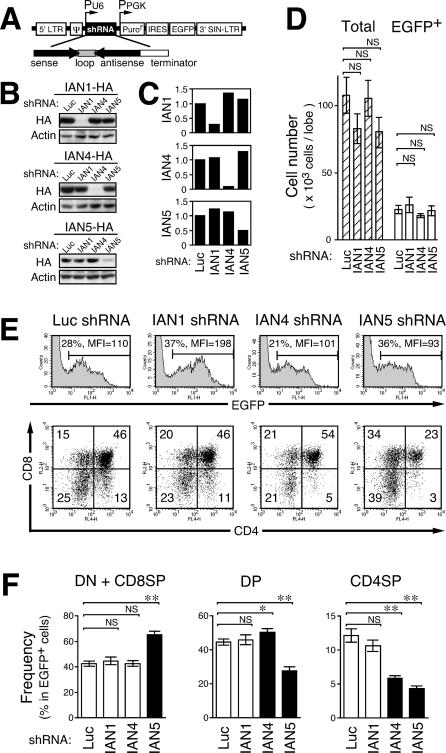
Knockdown of IAN1, IAN4, and IAN5 in Thymocyte Development(A) Diagram of retroviral shRNA constructs.Puro
r,
 puromycin resistance gene.
SIN-LTR, self-inactivating long terminal repeat.(B) BW5147 cells expressing IAN1-HA, IAN4-HA, or IAN5-HA were infected with shRNA retroviruses, and the infected cells were enriched by puromycin selection. Protein expression levels were analyzed by anti-HA IB.
Luciferase (Luc) shRNA was used as control.
(C) Day 14.5 fetal thymocytes infected with shRNA retroviruses were reconstituted in FTOC. EGFP
+ cells purified on day 6 were analyzed for mRNA expression.
(D) Viable cell numbers of total cells (striped bars) and EGFP
+ cells (open bars) in FTOC on day 6.
(E) EGFP histograms of total cells and CD4/CD8 profiles of EGFP
+ cells in FTOC on day 6. The frequency of EGFP
+ cells and the mean fluorescence intensity (MFI) in the indicated area are shown in the histograms. Numbers in dot plots show the frequency of EGFP
+ cells within boxes.
(F) Frequencies of indicated cell populations on day 6.Filled bars indicate significant difference from the values in the control group (
Luc shRNA) (
p < 0.05).
Bar graphs show means ± standard errors.NS, not significant (
p ≥ 0.05);
*
p < 0.05;
**
p < 0.01. In (D) and (F),
Luc shRNA,
n = 11;
IAN1 shRNA,
n = 5;
IAN4 shRNA,
n = 11;
IAN5 shRNA,
n = 8. No significant difference in the CD4/CD8 developmental profiles was observed in EGFP
− cell populations.